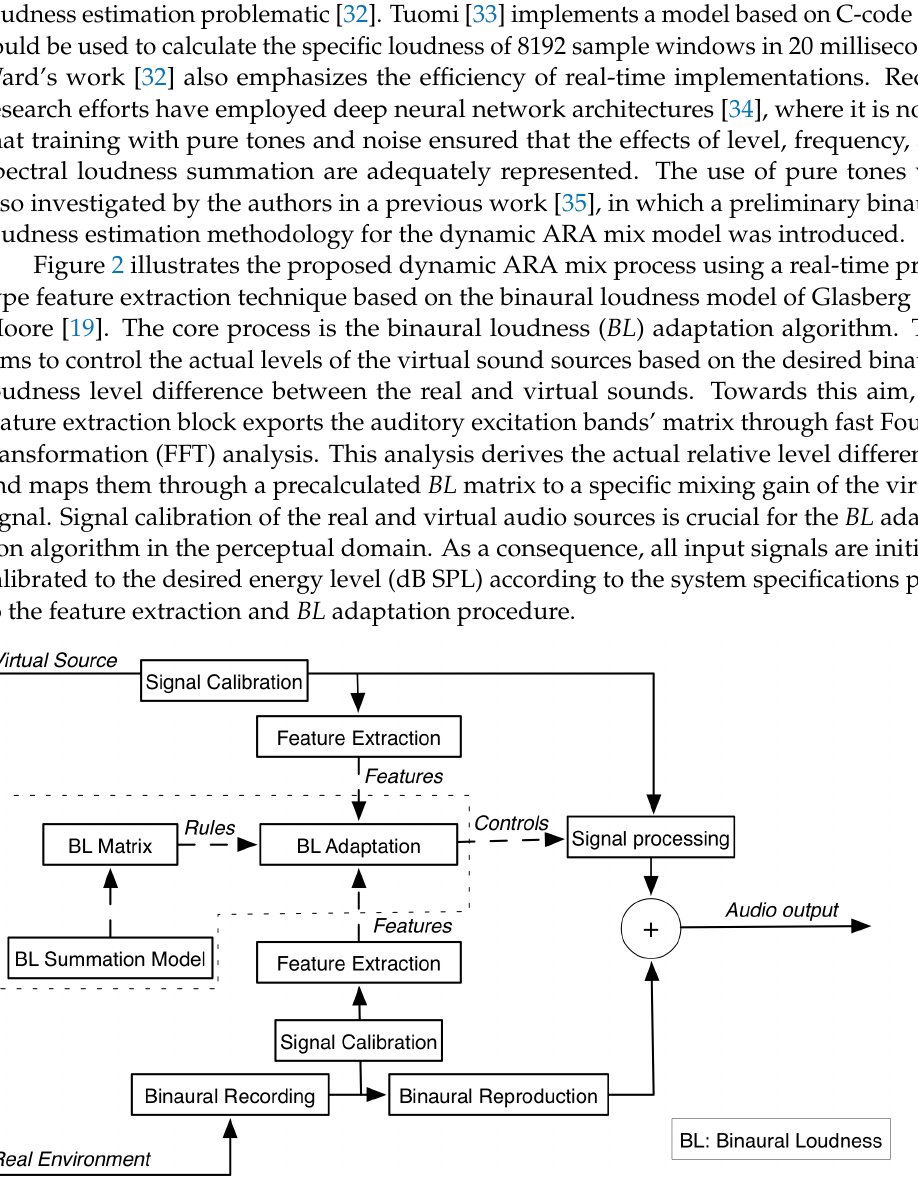
Figure 2. Overview of the architecture of the proposed dynamic ARA mix